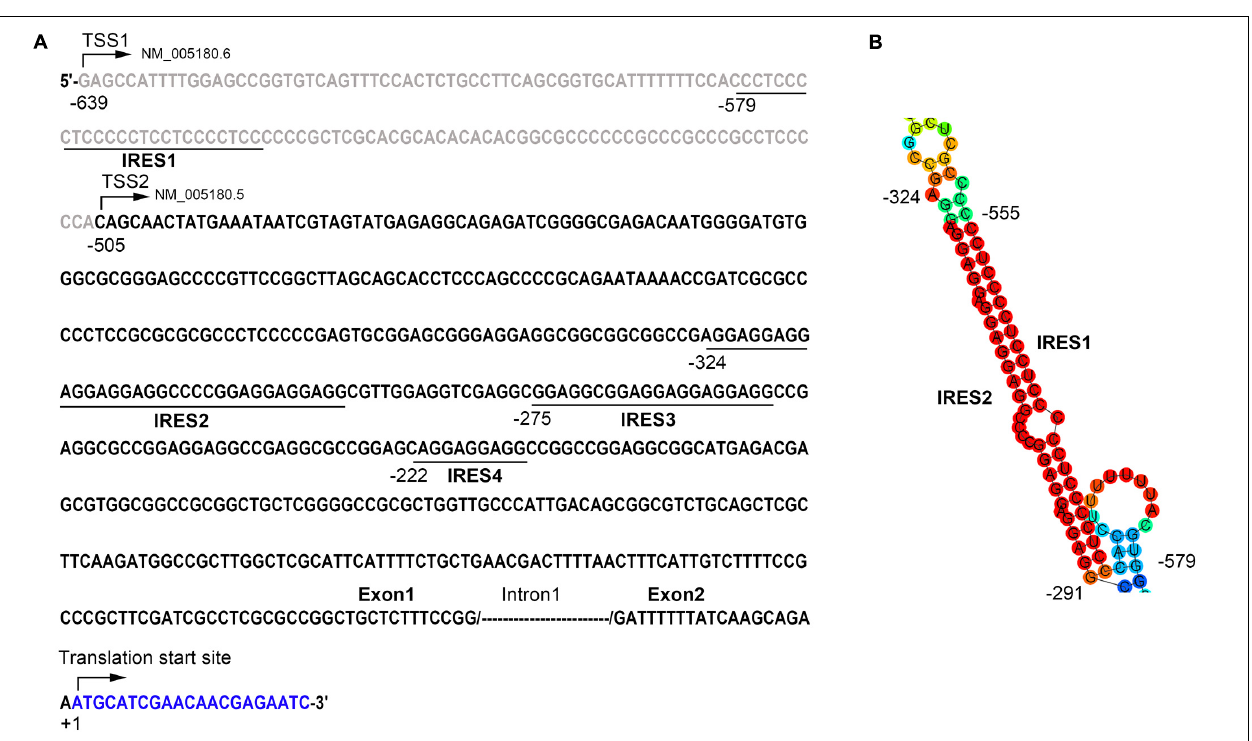
Frontiers in Oncology |